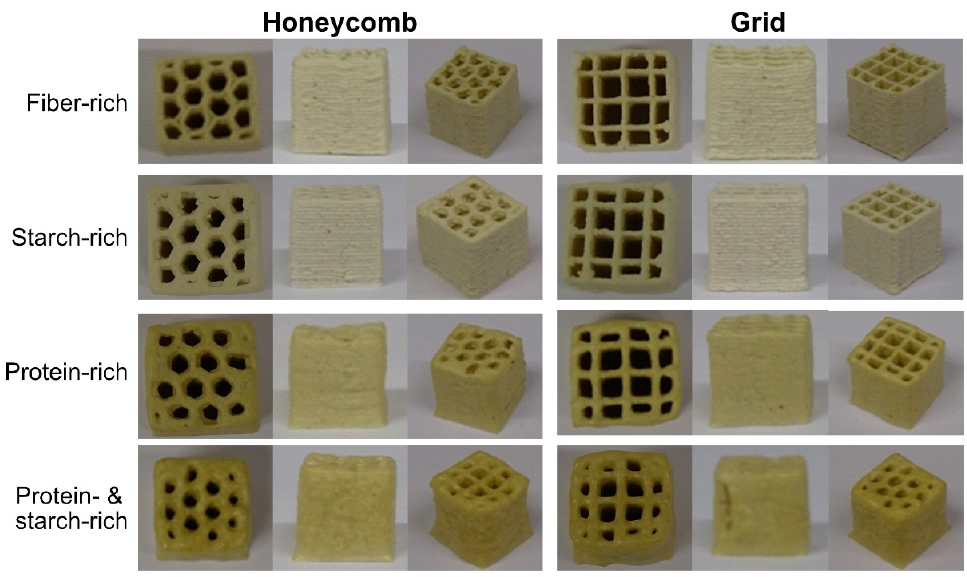
Figure 1. 3D printed cubes (14 × 14 × 14 mm) after freeze-drying.